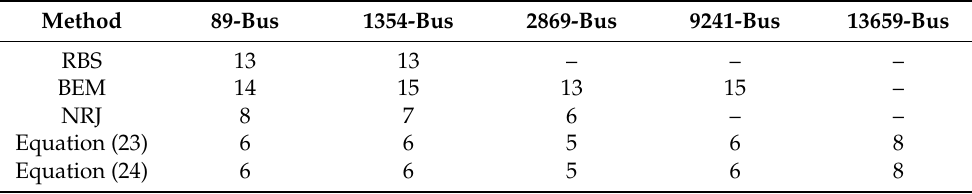
Table 9. Total number of iterations at the maximum loadability